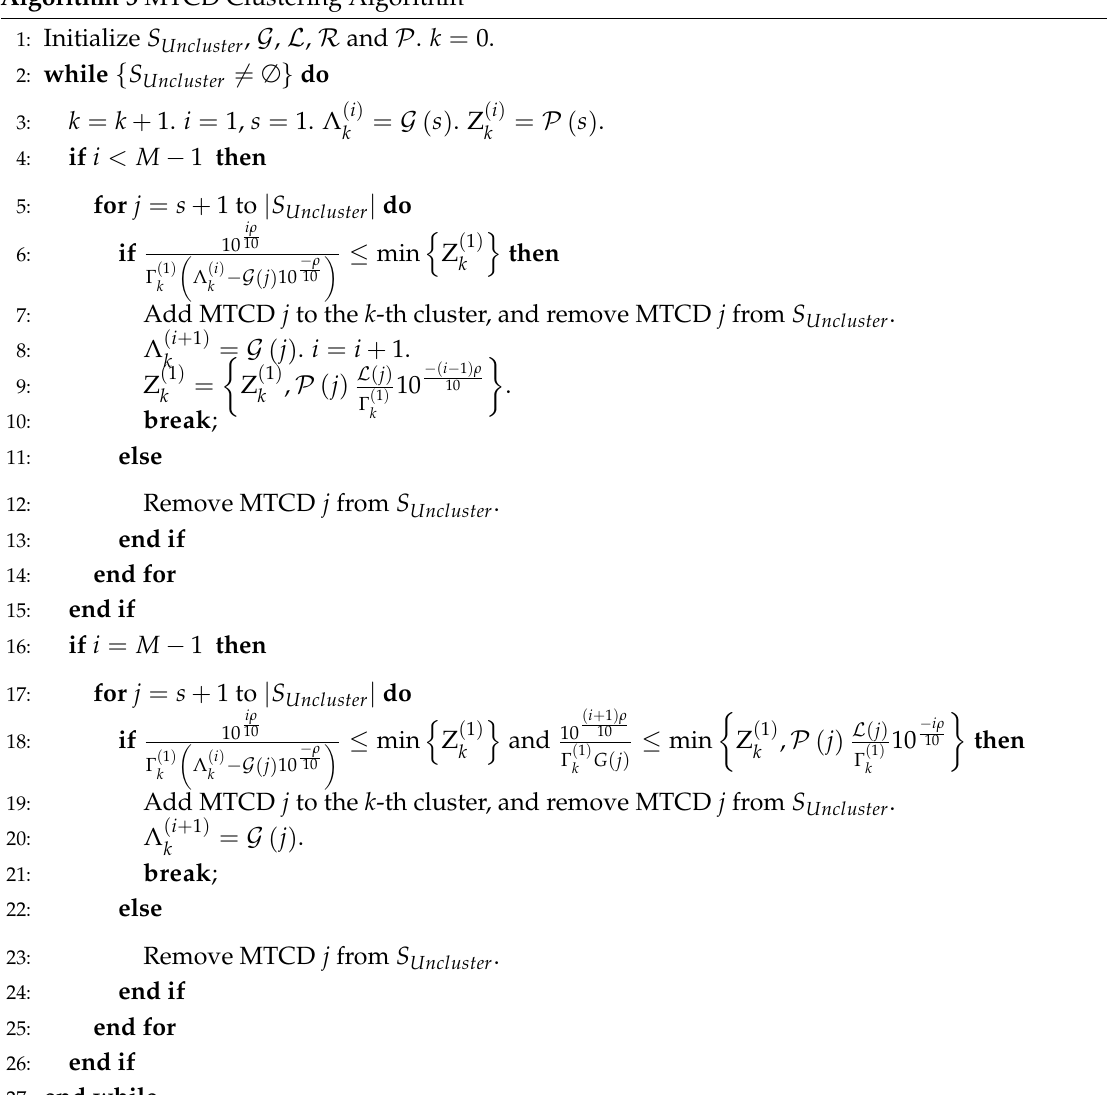
Algorithm 5 MTCD Clustering